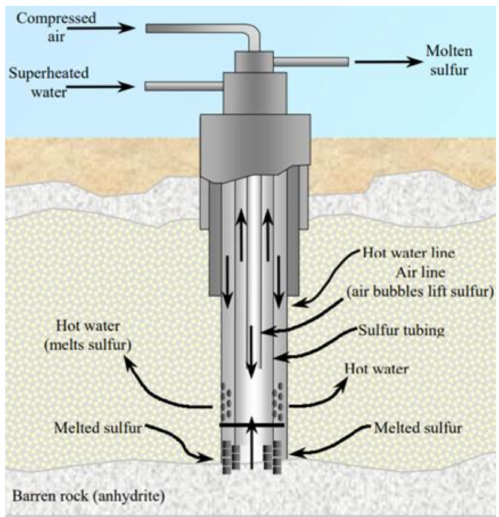
Figure 5. Schematic shape of Frasch pump (courtesy of USGS